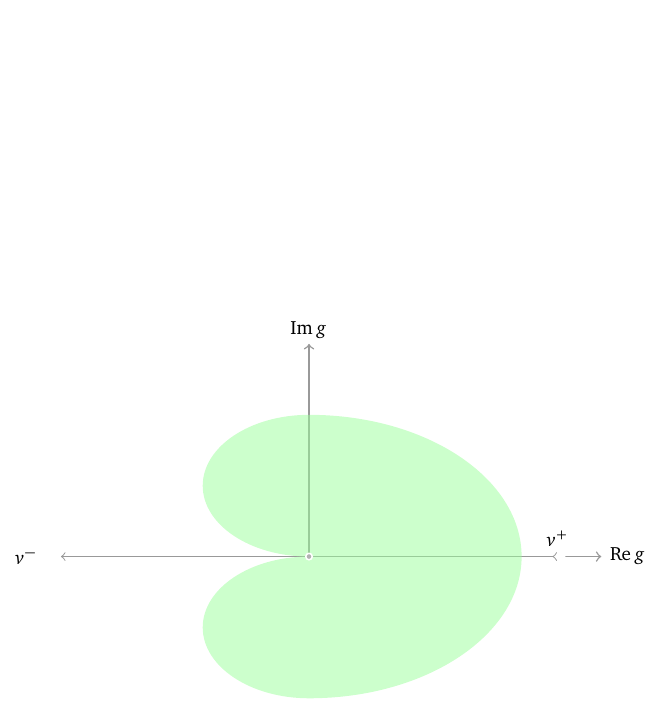
Figure 12: A unique attracting petal of a multiplicity 2 parabolic